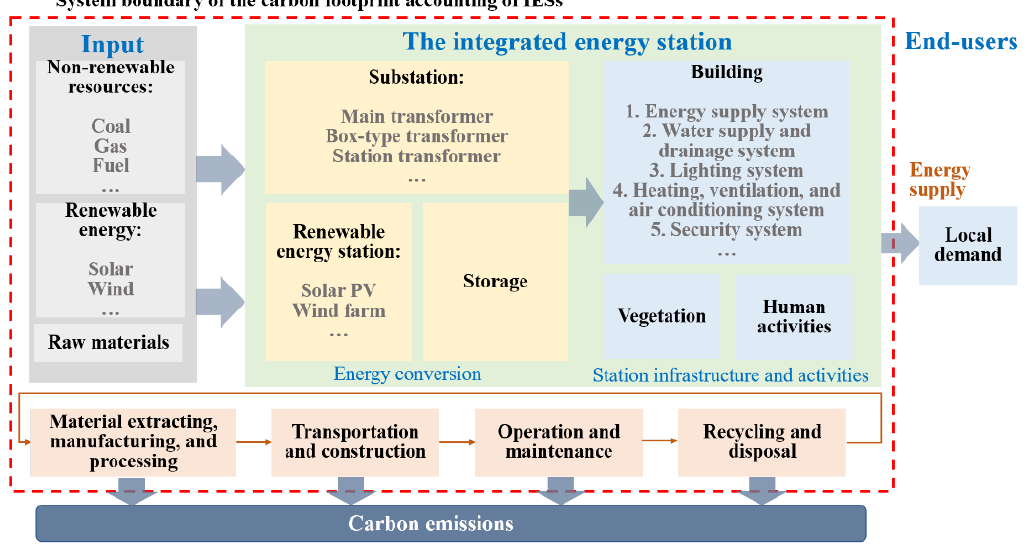
Figure 1. System boundary of the IES carbon emission accounting.